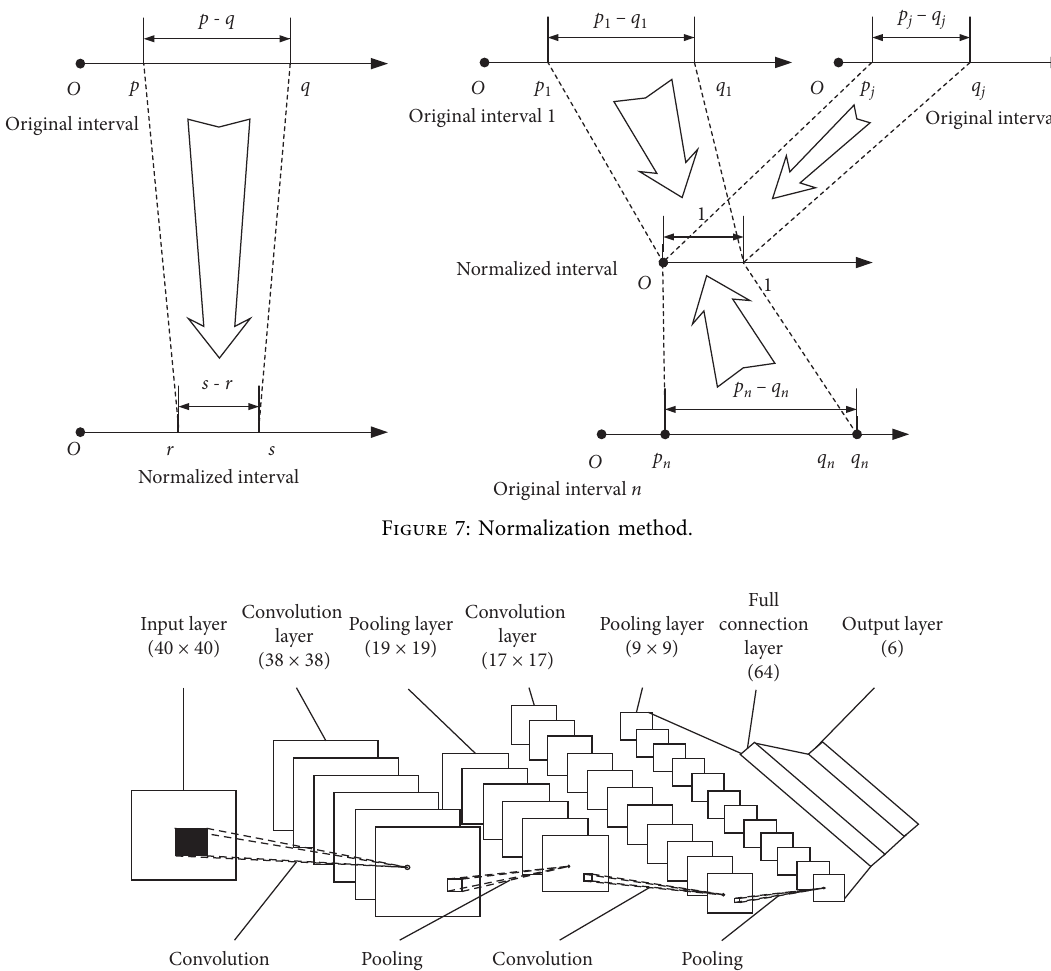
Figure 8: The model of the convolution neural network.